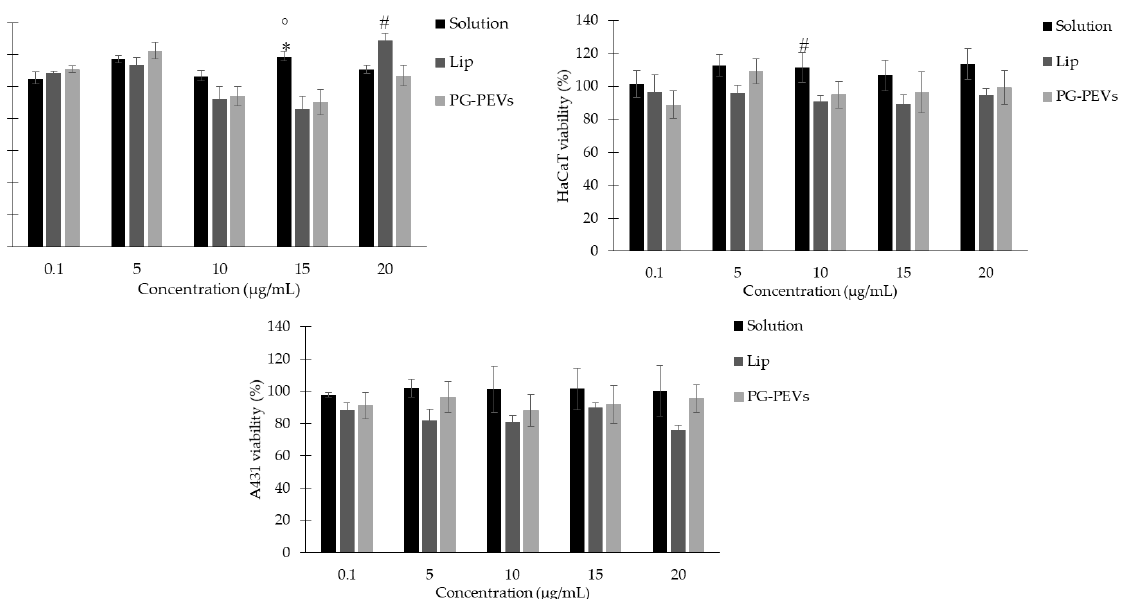
Figure 5. Viability of 3T3, HaCaT, and A431 cells upon exposure to P. spinosa samples for 24 h. Data are expressed as means ± standard error (SE) from two independent experiments, each performed in triplicate. For 3T3: * p < 0.05 vs. lip, ◦ p < 0.05 vs. PG-PEVs, # p < 0.05 vs. PG-PEVs; for HaCaT: # p < 0.05 vs.